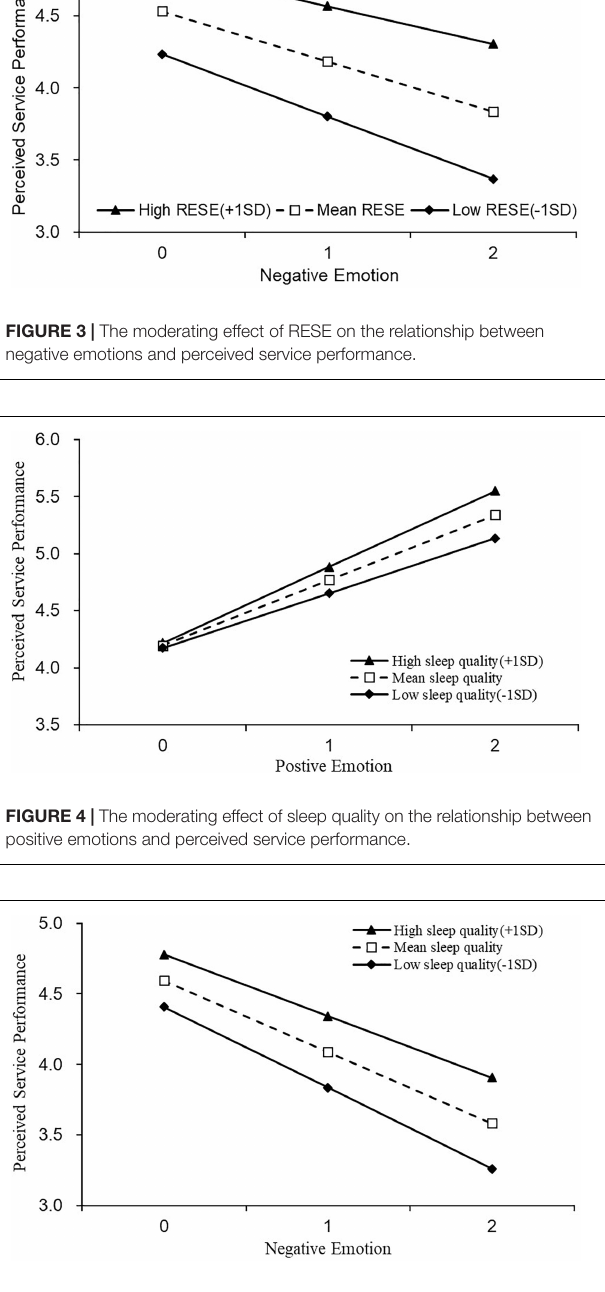
FIGURE 5 | The moderating effect of sleep quality on the relationship between negative emotions and perceived service performance.